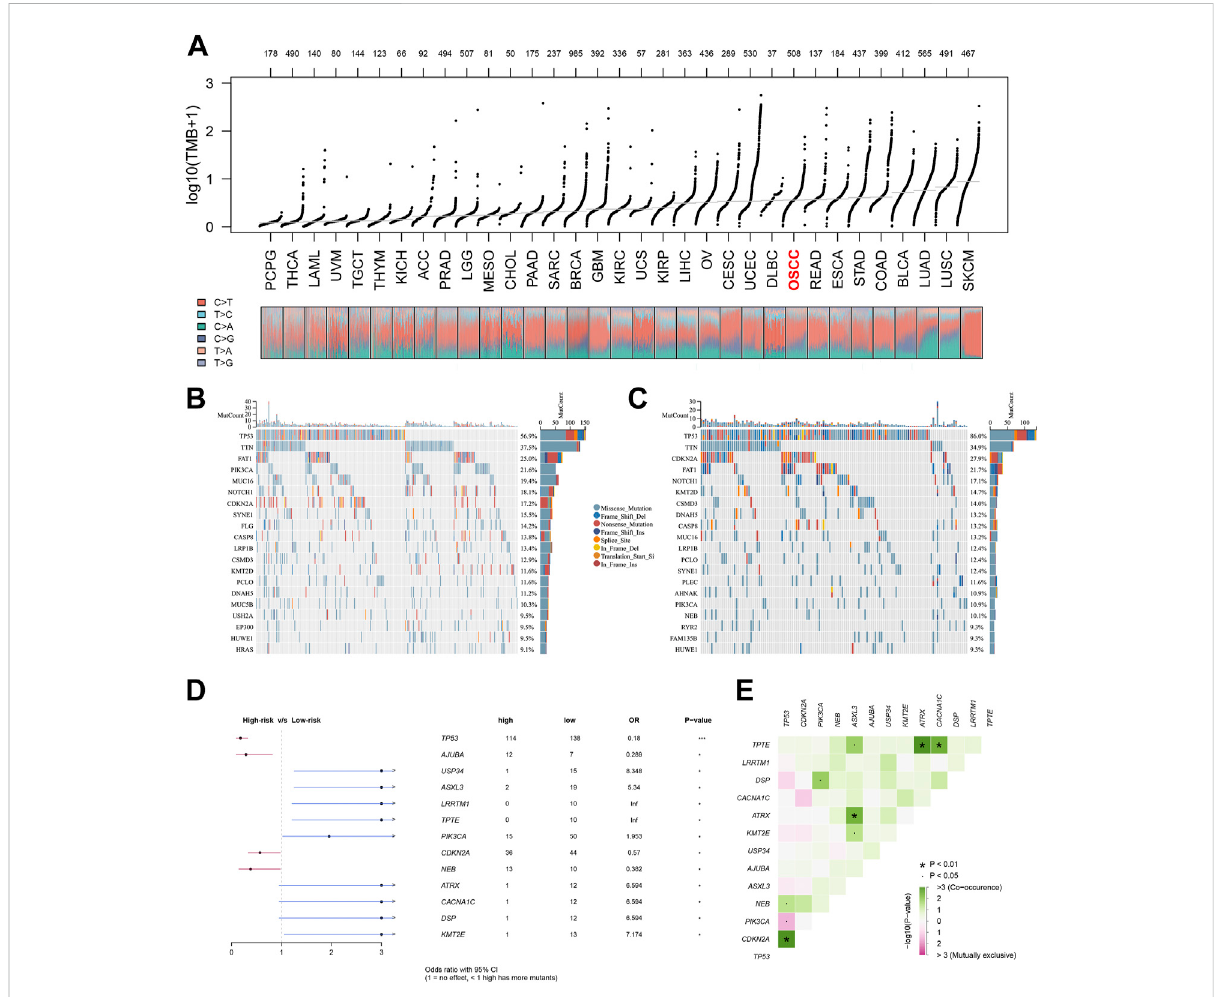
FIGURE 6 Tumormutationalanalysisofthesignature.Notes: (A) DistributionofTMBvaluesofalltumorsinTCGAdatabase. (B , C) Mutationallandscapesof both high-risk group and low-risk groups. (D , E) Forest plot of differentially mutated genes in patients between two risk